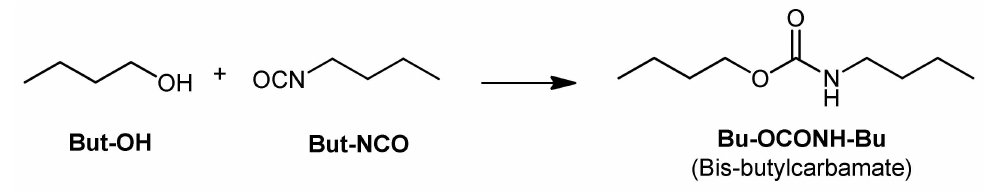
Figure 7. Reaction between butylisocyanate and 1-butanol.